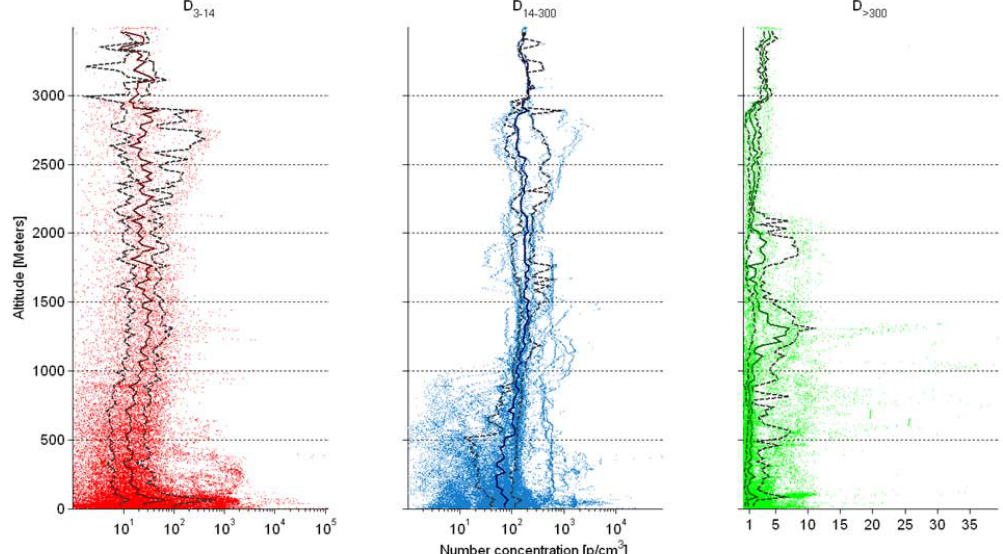
Fig. 7. Vertical aerosol number size concentration profiles taken across 38 flights carried out during the ice drift of the ASCOS 2008 expedition. The three sub-plots show concentrations of particles with diameters of 3–14nm, 14–300nm and over 300nm respectively. Points are individual observations, the continuous line is the median of the measurements and the dashed lines are the upper and lower quartiles of the